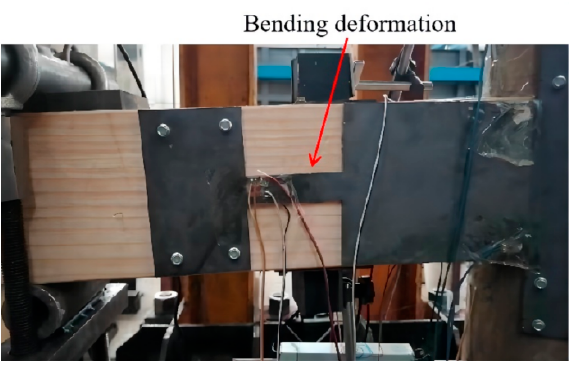
Figure 6. Bending deformation of the energy dissipation section of the metallic damper.